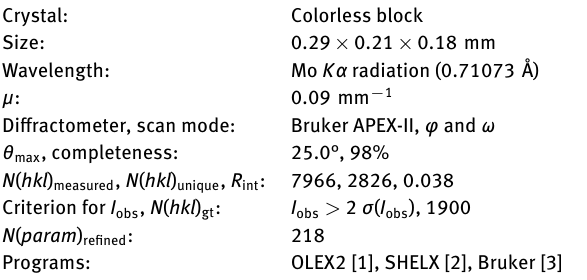
Table 2: Fractional atomic coordinates and isotropic or equivalent isotropic displacement parameters (Å 2